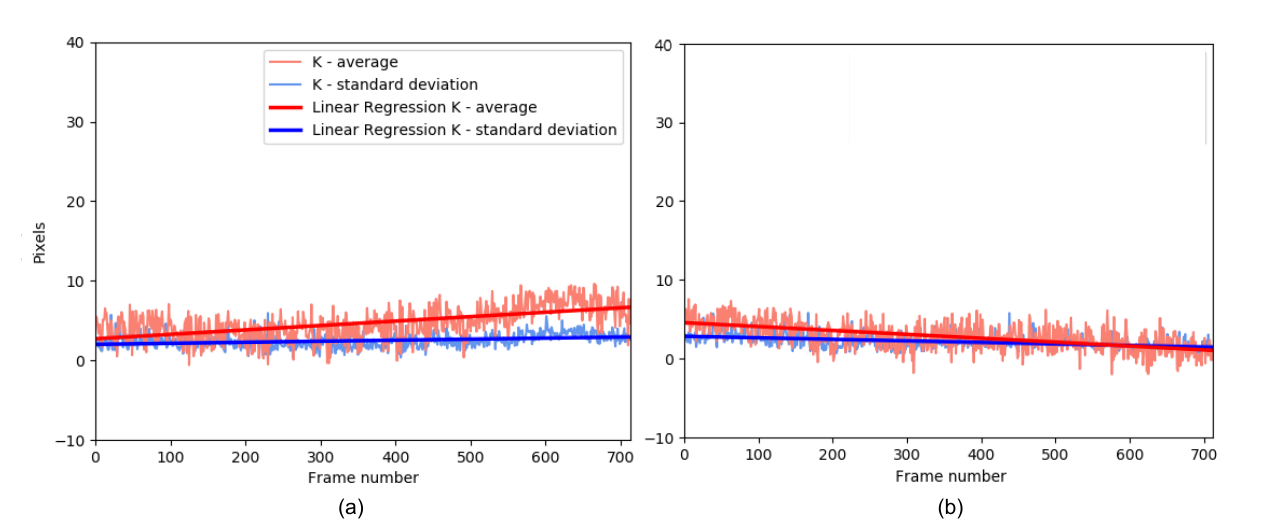
Figure 7. Example of the application of linear regression to K parameters: ( a ) example of positive slope, ( b ) example of negative